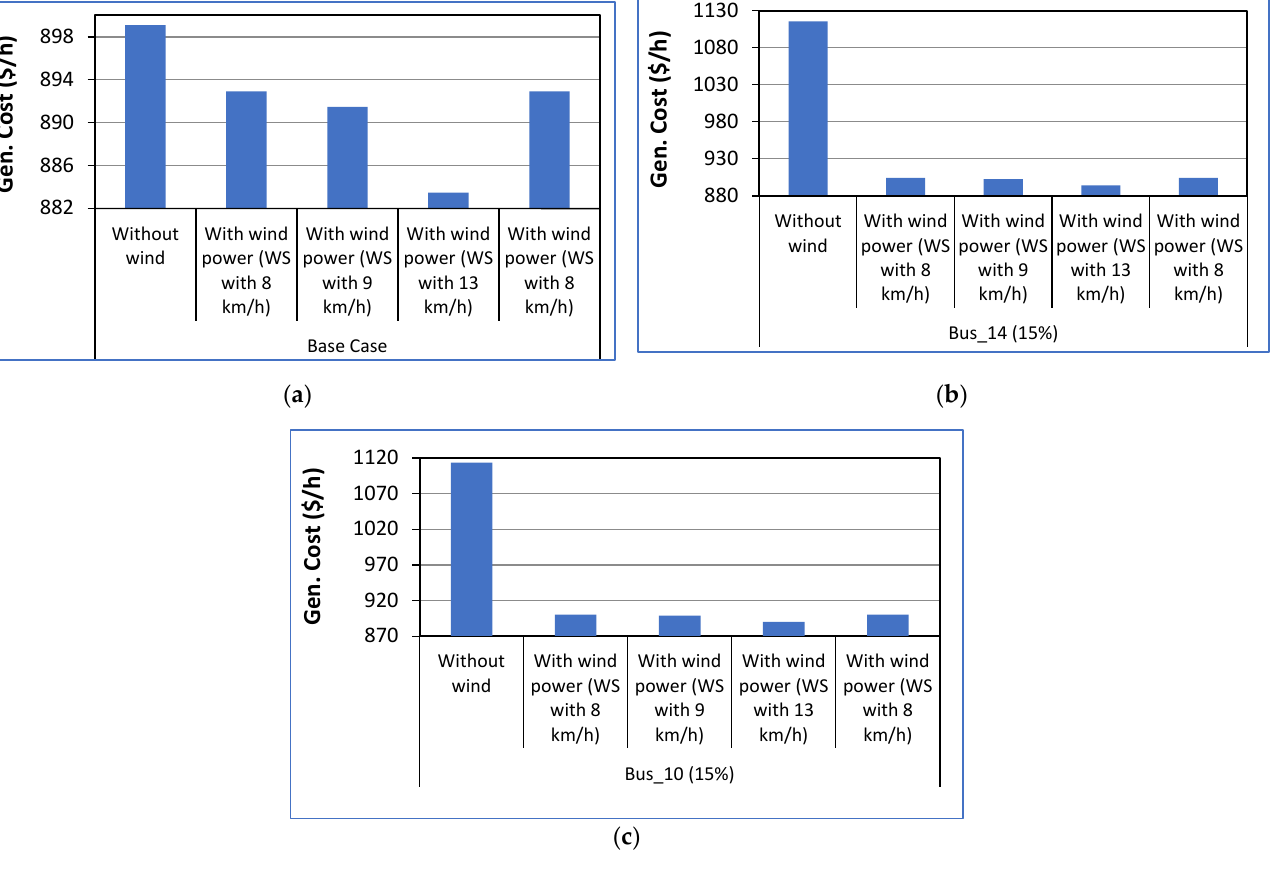
Figure 4. System Generation Costs ($/h) with Wind Power Integration (Kolhapur). Base case ( a ), Bus-14 15% ( b ), Bus_10 15% ( c ). Table 4. System Risk and Profit with Wind Power Integration